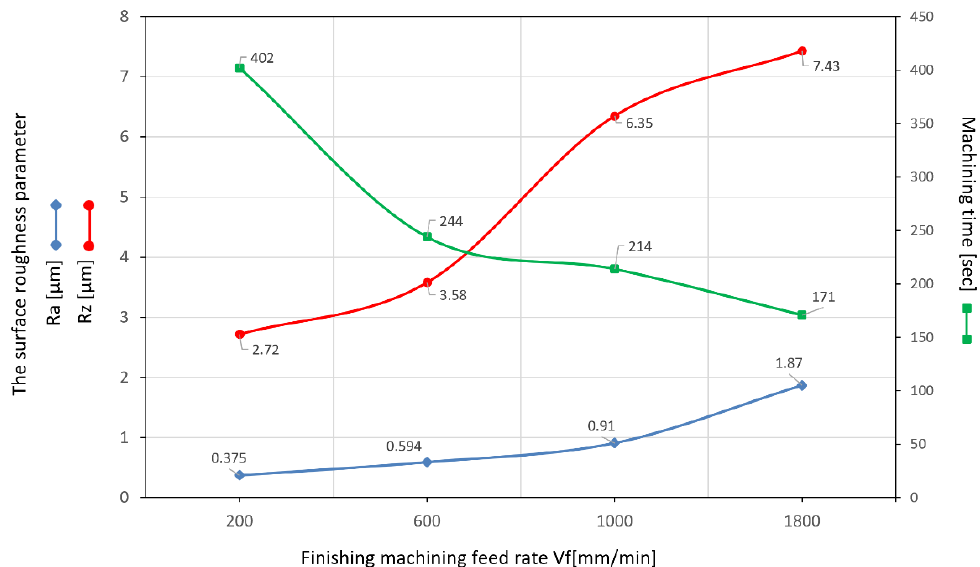
Figure 10. The measured roughness profile Ra and Rz parameters, measured longitudinally to the tooth profile. The results of machining time as a function of feed rate.